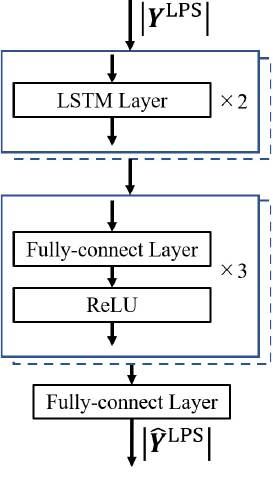
Figure 4. Structure of DNN for amplitude spectrum reconstruction.